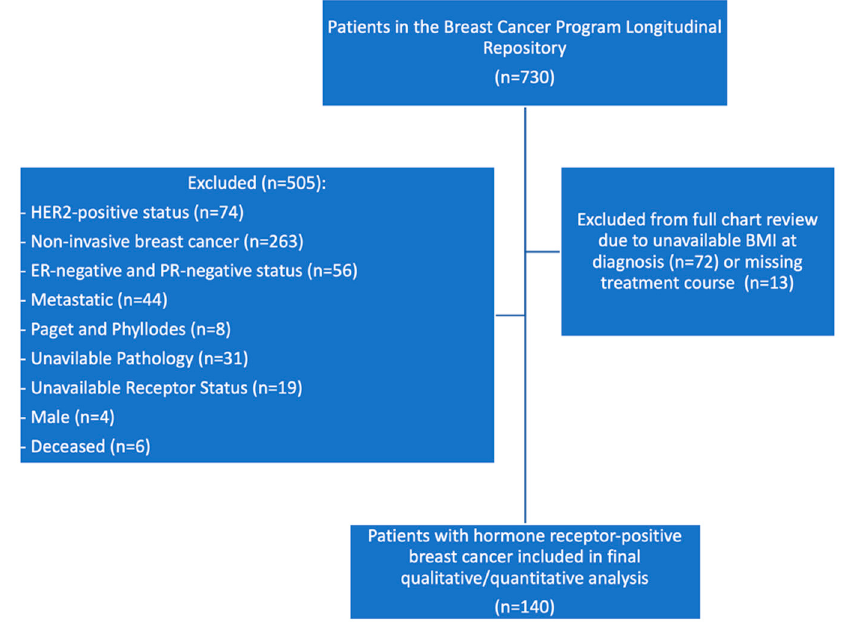
Figure 1. Flowchart of included participants.